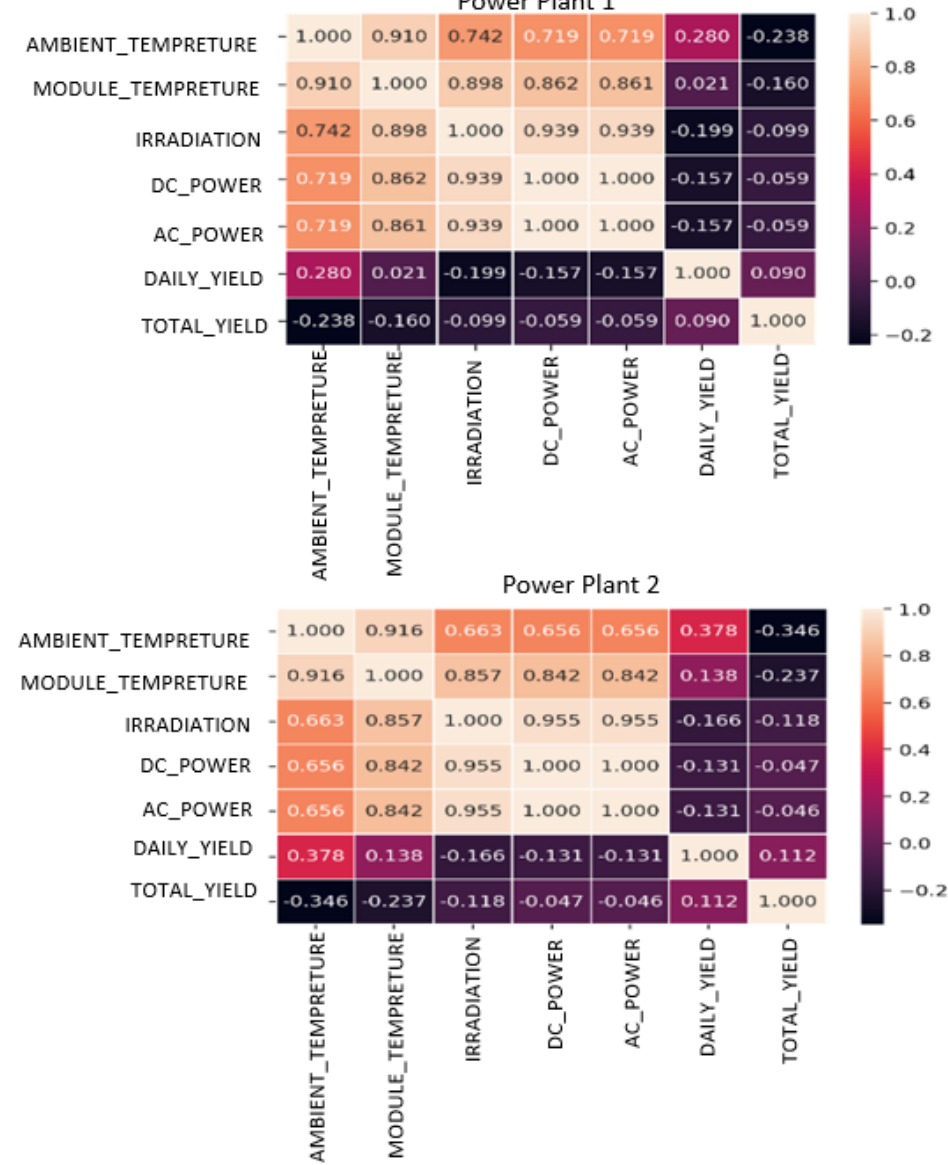
Figure 3. Correlation matrix computing the linear correlation among the characteristic elements for power plants 1 and